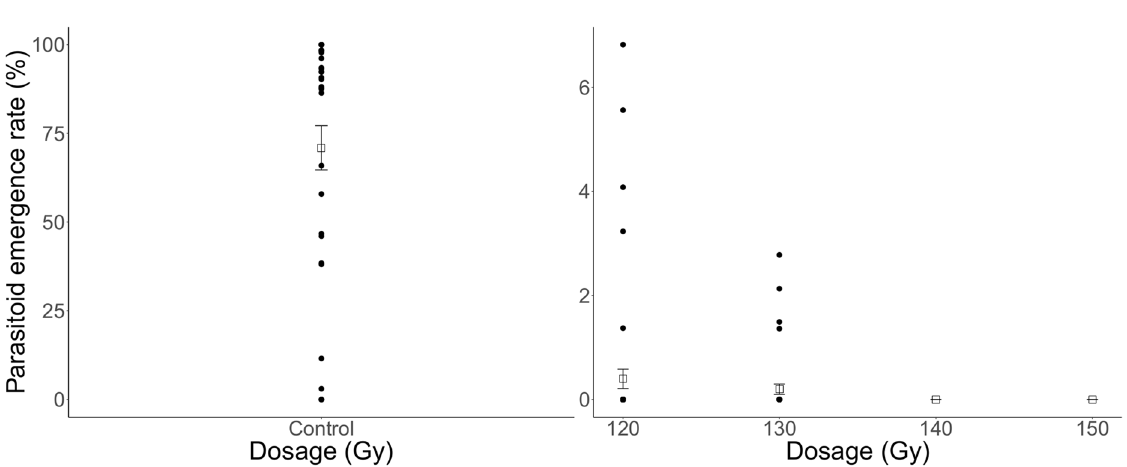
Figure 2. Lifetime percentage of Nezara viridula eggs attacked by irradiated and non-irradiated female Trissolcus basalis , which resulted in emerged offspring of the latter. Squares and error bars represent means and standard error,